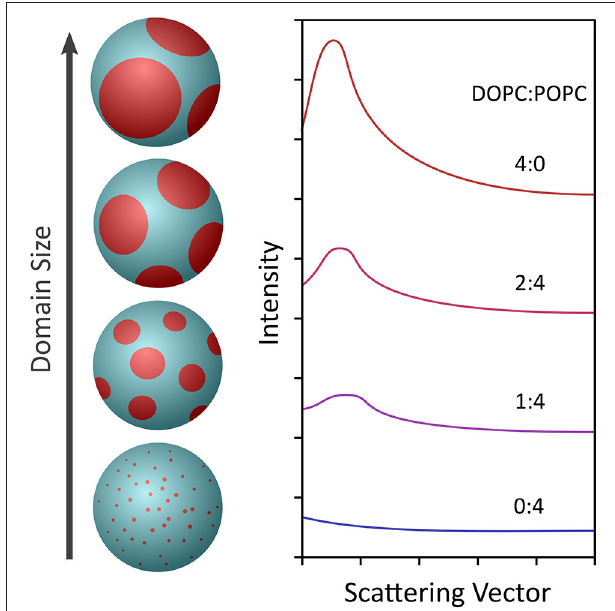
FIGURE 5 | Schematic showing the use of contrast variation to observe the formation of nanoscopic lipid domains in 60 nm diameter ULVs (left) made from a lipid composition (i.e., DSPC/DOPC/POPC/cholesterol) mimicking the outer leaflet of a mammalian PM. At a DOPC:POPC ratio of 0:4, the domains were extremely small, producing minimal scattering (right). However, as the amount of DOPC with respect to POPC increased, the domains grew larger and the scattering signal increased. The scattering data were fitted using Monte Carlo simulations, which gave an indication of the diameter and number of nanoscopic domains in a ULV of given lipid composition. Figure adapted from Heberle et al.